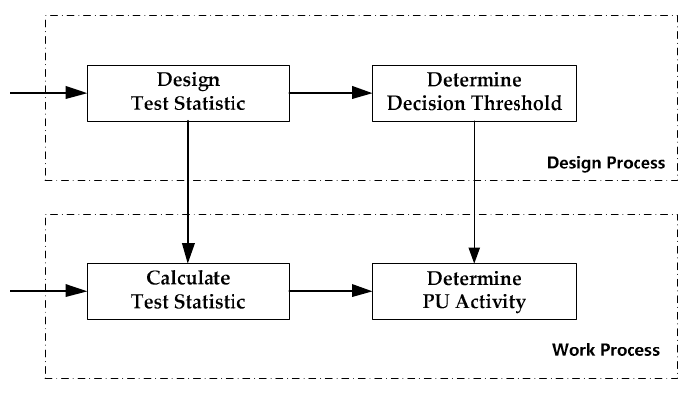
Figure 1. The steps of typical spectrum sensing.